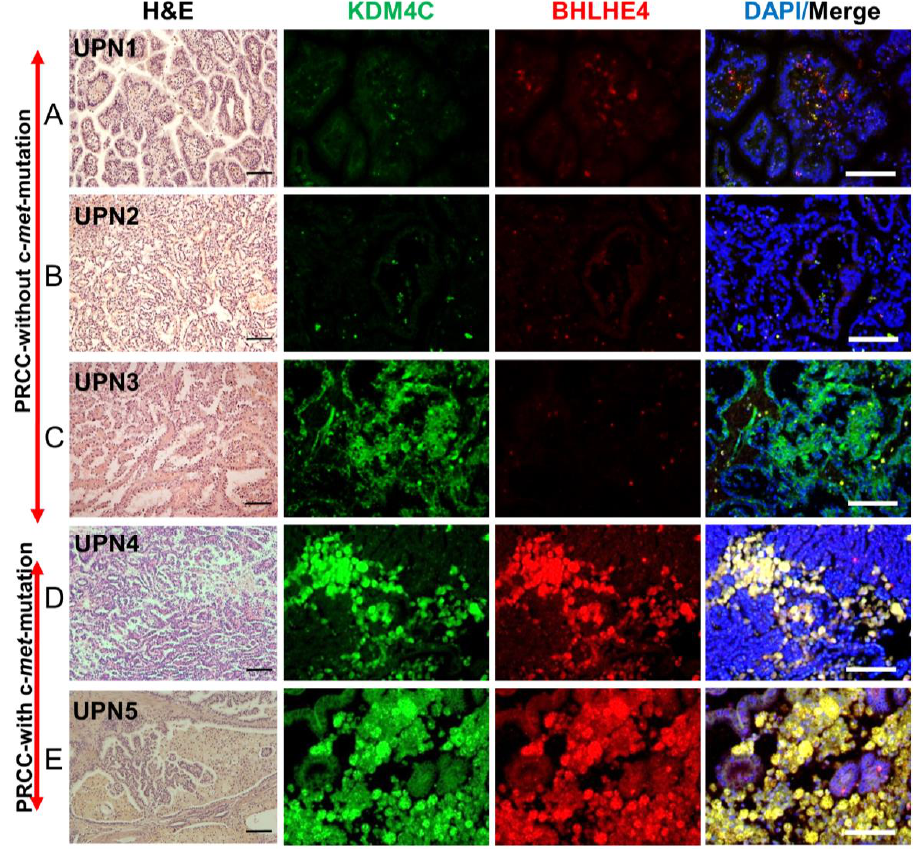
Figure 7. Immunohistochemistry of primary kidney cancer samples from patients without and with c- met mutated PRCC . Hematoxylin-eosin (H&E) staining and immunohistochemistry for KDM4C,